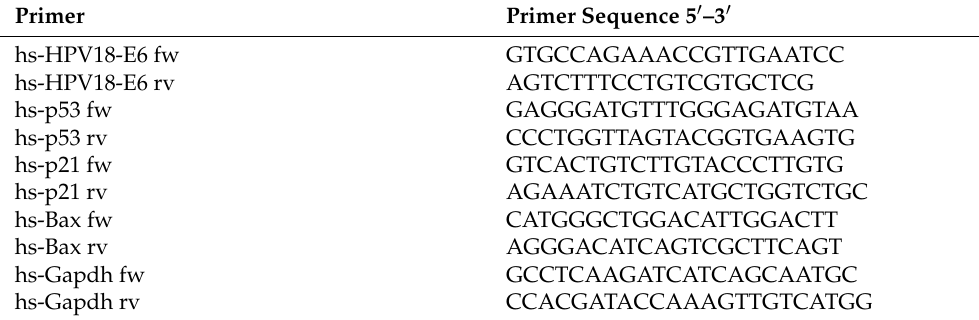
Table 4. Primer sequences used for real-time